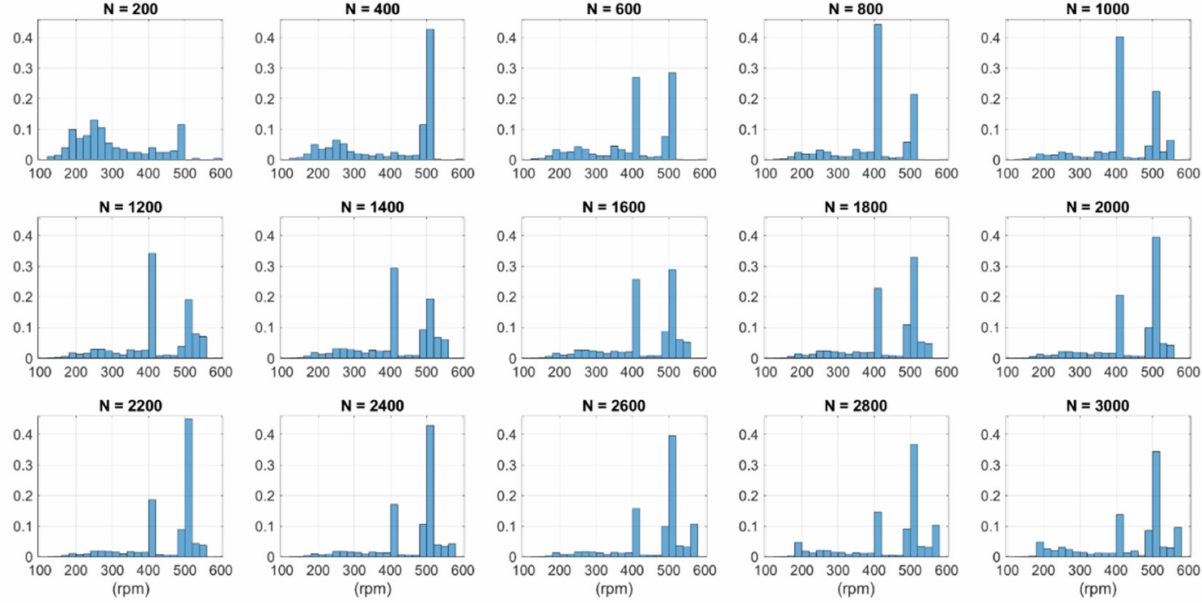
Figure A1. Distributions of rotational speed values in datasets of different sizes (N) shown as histograms with 20-rpm bin size. The vertical axes show the relative number of observations, i.e., the sum of all bar heights is equal to